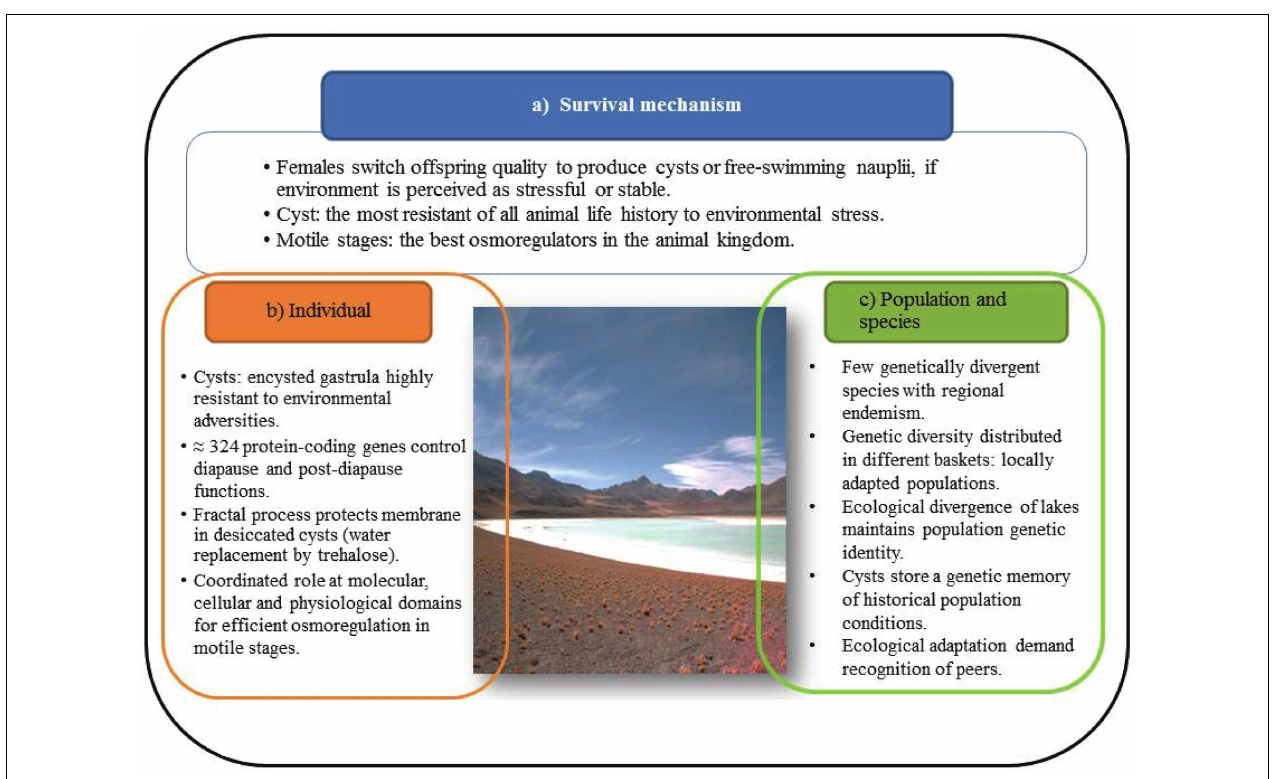
FIGURE 2 | Salty lakes impose critical conditions on reproduction of individuals, populations, and species. Adaptation to such conditions has evolved a network of different functional and hierarchical